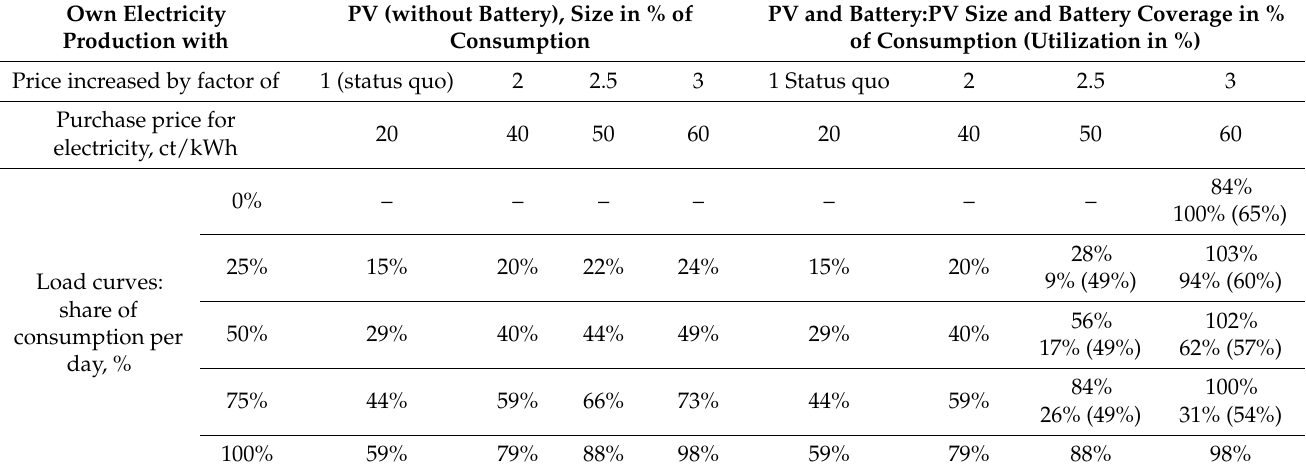
Table 10. Power generation technology: size of PV system and battery, and battery utilization in % post-RESA. PV and Battery: PV (without Battery), Own Electricity Production with PV Size and Battery Coverage in % of Consumption Size in % of Consumption (Utilization in %) 1 (status Price increased by factor of quo) Purchase price for electricity,